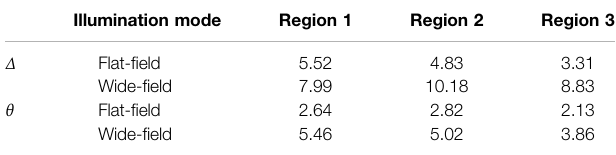
TABLE 1 | Comparison of the FWHM in three regions.